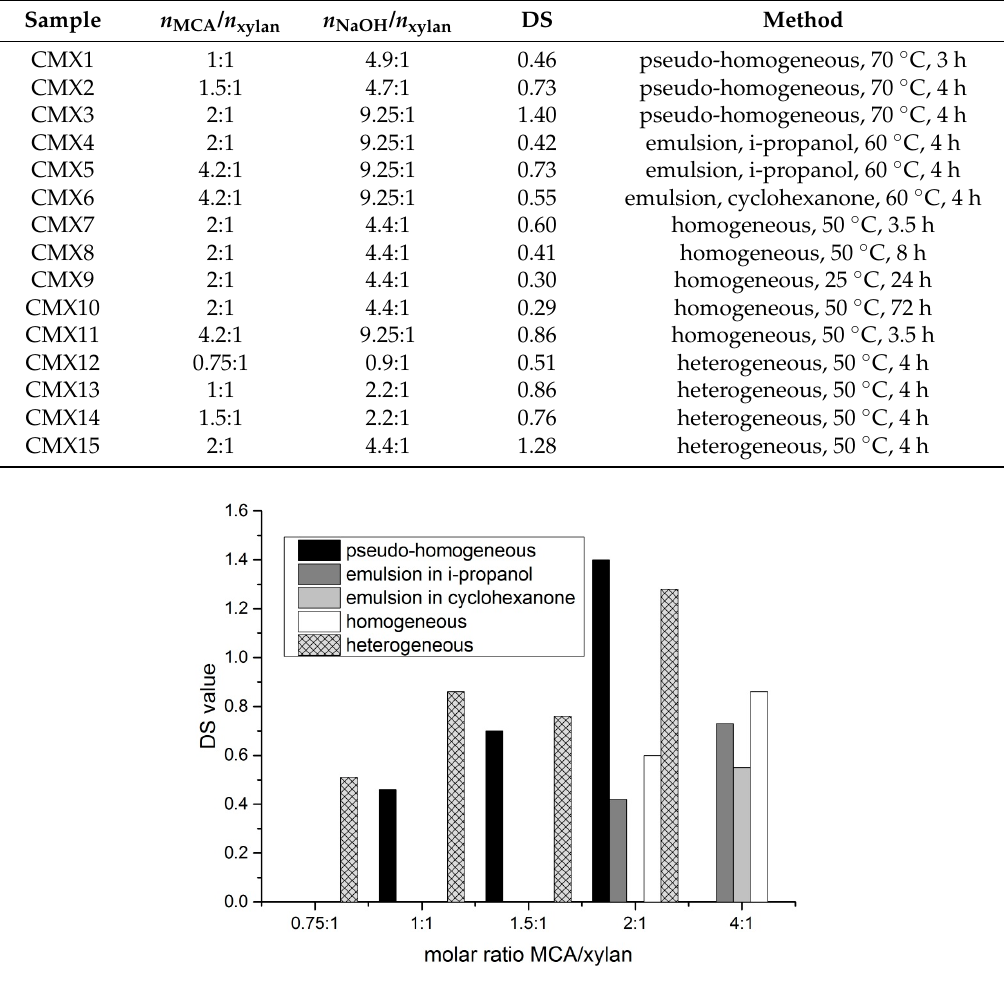
Figure 7. Effect of the reaction conditions on the DS values of xylan, achieved with monochloro acetic acid (MCA).